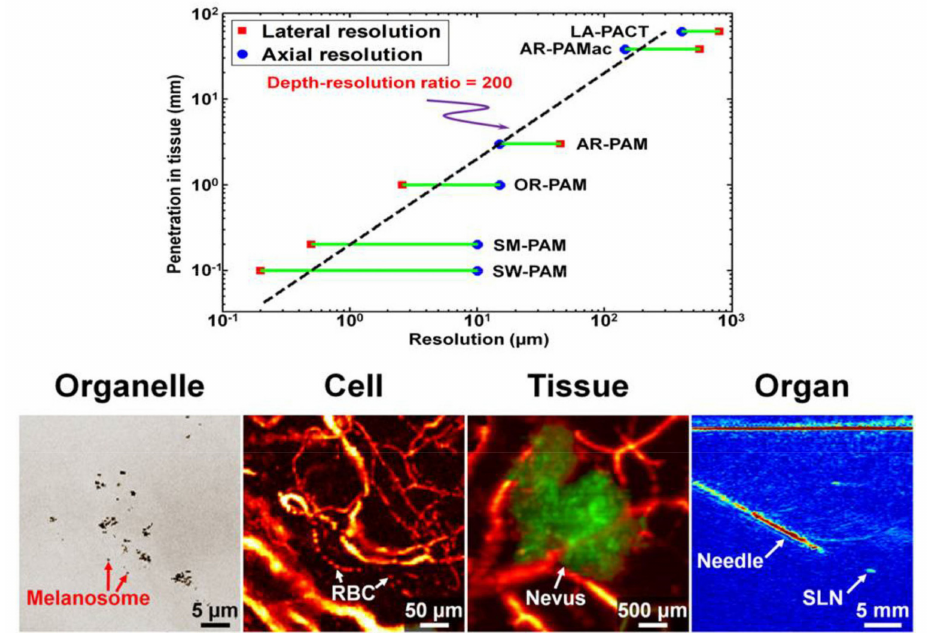
Figure 9. The multiscale capability of PAI. Figure reprinted with permission from